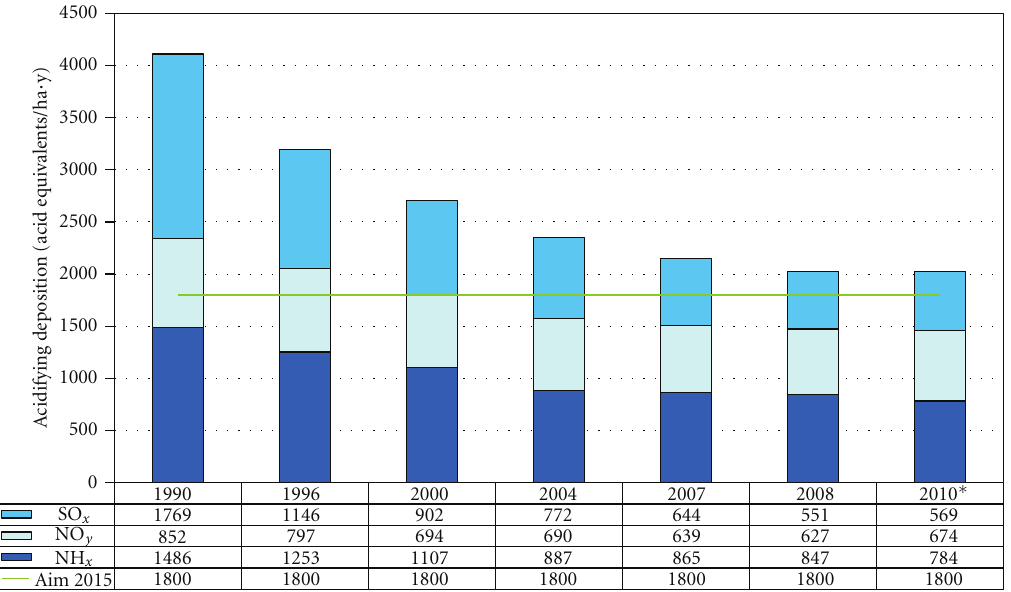
FIGURE 5: Average Flemish acidifying depositions of SO x , NO y , and NH x from 1990 to